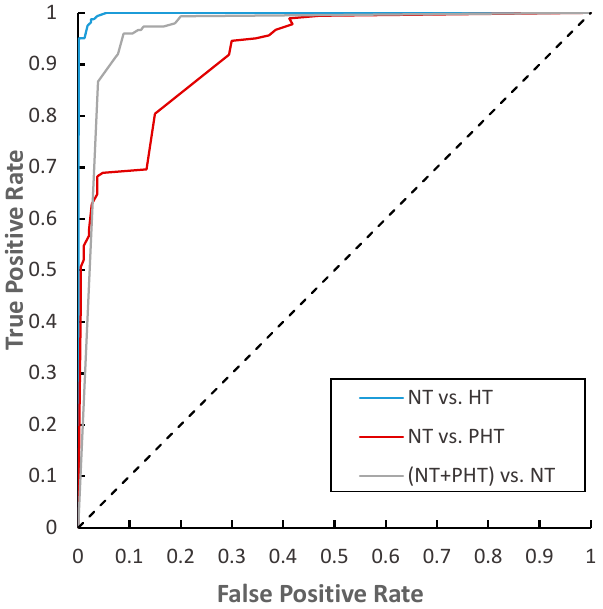
Figure 6. The ROC (receiver operating characteristic) curve of the three classification trials of AlexNet.